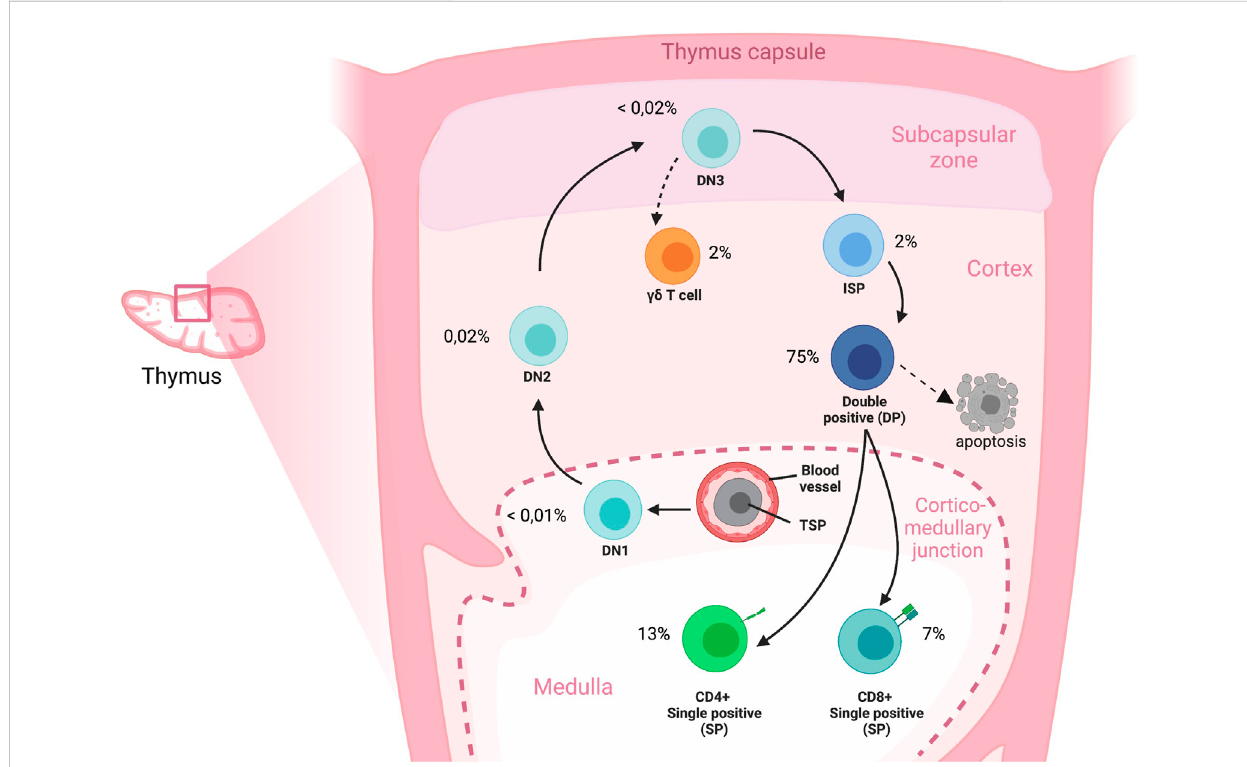
Overview ofTcell development inthehumanthymus. Crosssection ofan adultthymic lobulerepresenting themigration routeofT-cellprecursors during development. Immigrant precursors move to the thymus through blood vessels and enter near the corticomedullary junction; the TSPs subsequentlymigrate,anddifferentiatetoDN,DPand fi nallytoSPstagesthroughthediscretemicroenvironmentsofthethymus.Adirectionalreversalof migration back across the cortex towards the medulla occurs for the later stages of thymocyte development. The cell percentages represent the proportions of cell types compared to the total cell composition in the human thymus. DN: Double negative; DP: Double positive; ISP: Immature single positive; SP: Single positive; TSP: Thymic seeding